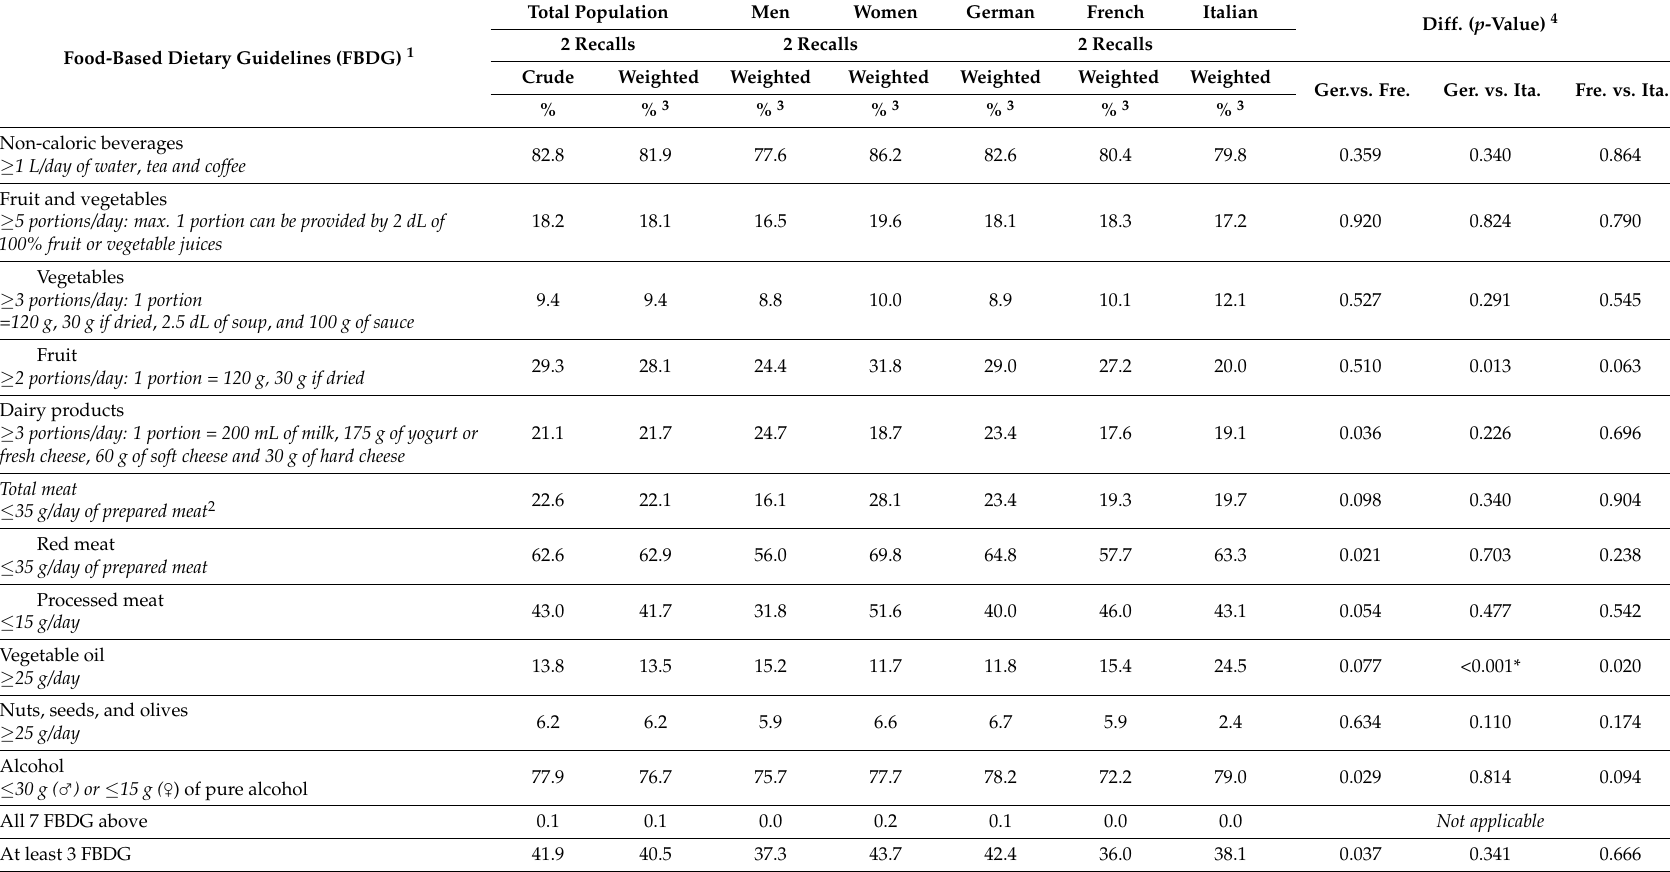
Table 4. Proportion of participants following the seven food-based dietary guidelines, total, by sex and linguistic region. Total Population Men Women Food-Based Dietary Guidelines (FBDG) 1 Crude Weighted Weighted Weighted Weighted Weighted Weighted